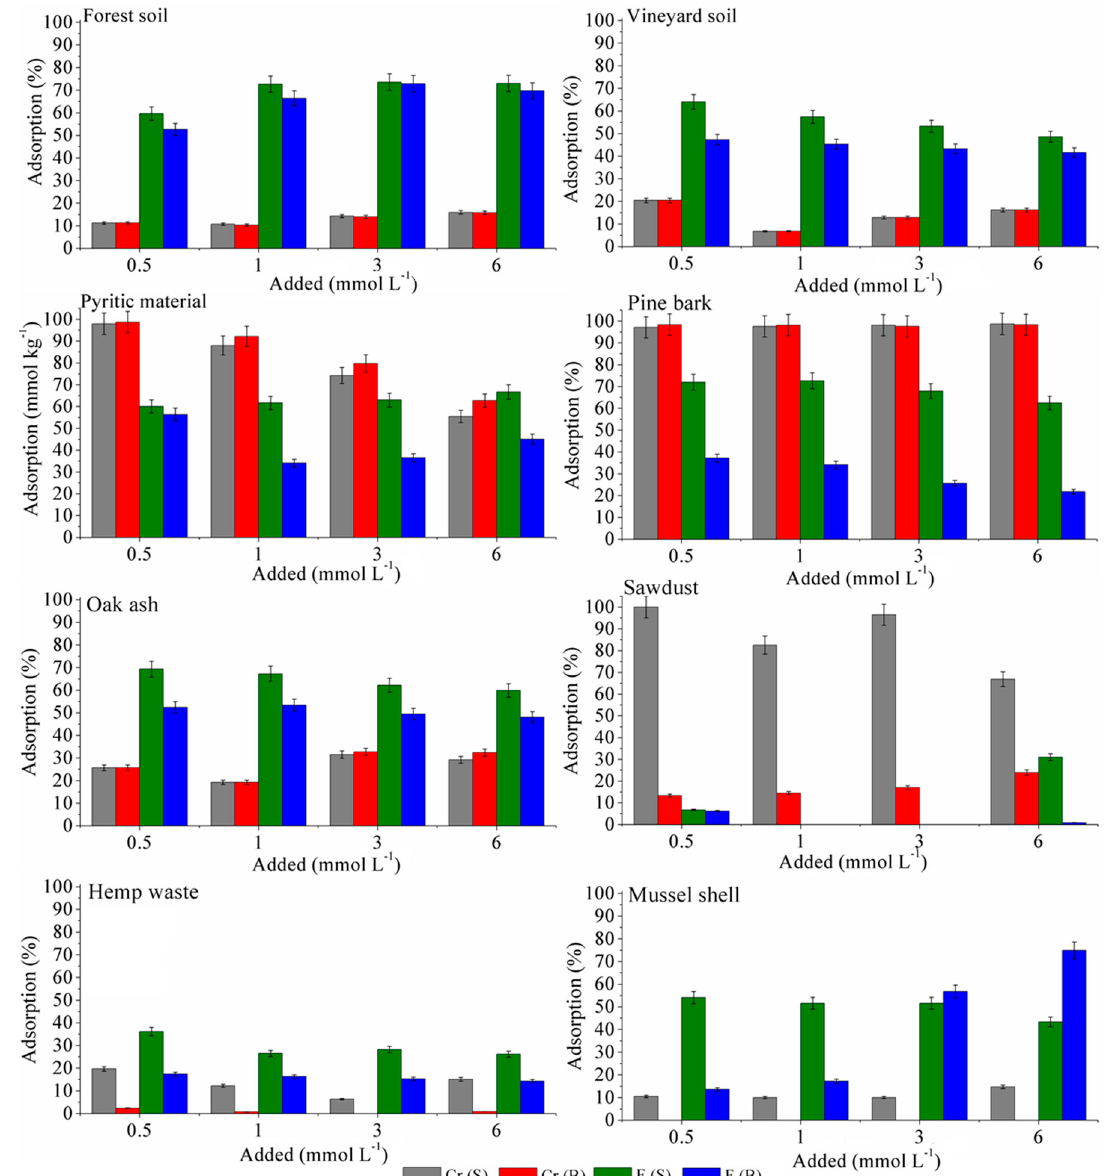
Figure 1. Percentage adsorption for Cr(VI) and F − in the various soils and sorbents tested, in simple (S) and binary (B) systems. Average values for three replicates, with error bars showing that coefficients of variation were <5%.